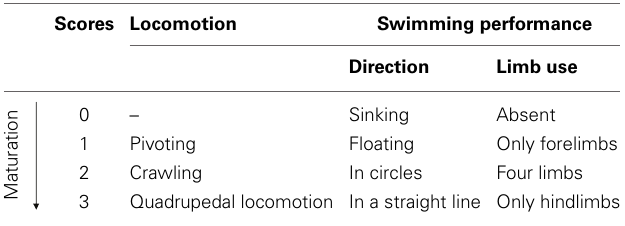
Table 1 | Rating scale for locomotion and swimming performance. Scores